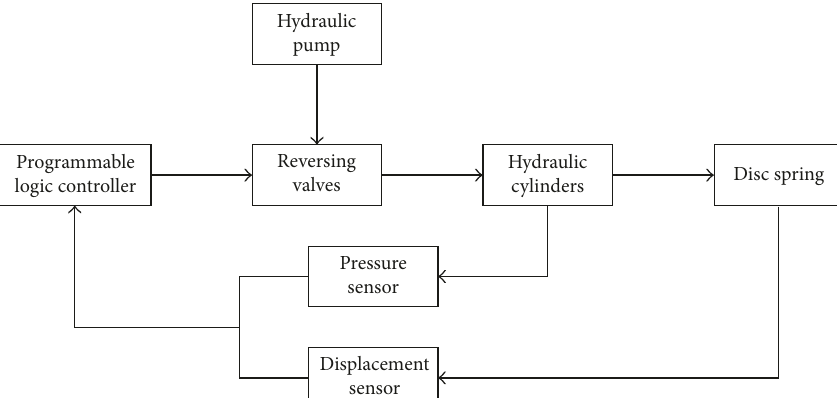
Figure 4: Hydraulic control system